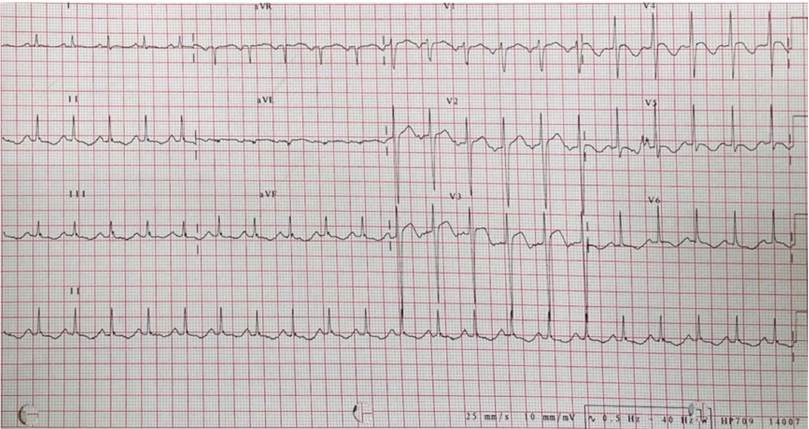
Figure 1. Electrocardiogram showed sinus tachycardia and ST-elevations in leads V2 and V3; ST-depression in leads II, III, aVF, and